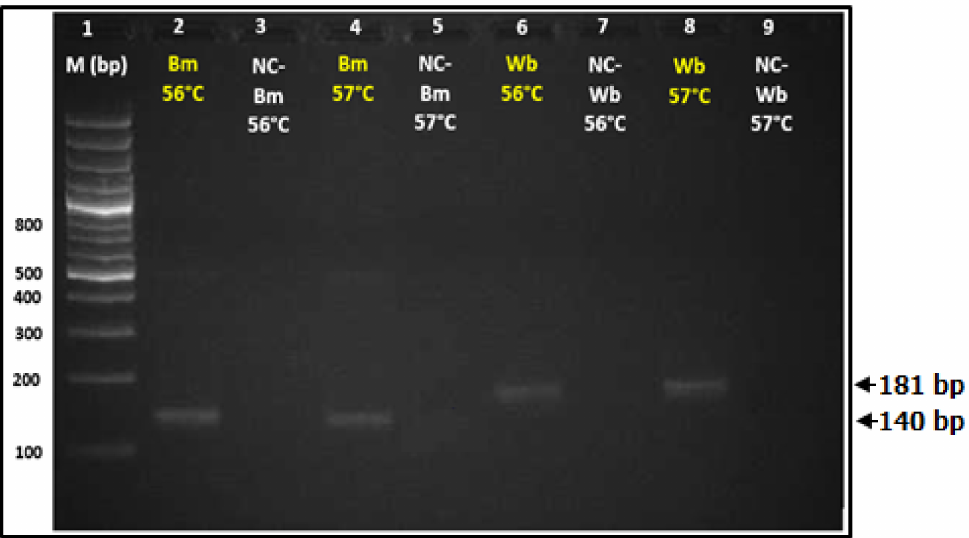
Figure 3. Optimized condition of standard PCR assay for detection of B. malayi and W. bancrofti DNA. 2% agarose gel electrophoresis showed the amplified Hha1 gene of B. malayi and Ssp I gene of W. bancrofti at difference annealing temperature (56 ◦ C and 57 ◦ C). Lane 1: 1.5 kb DNA ladder; Lane 2, 4: DNA template of B. malayi ; Lane 3, 5: negative control of B. malayi ; Lane 6, 8: DNA template